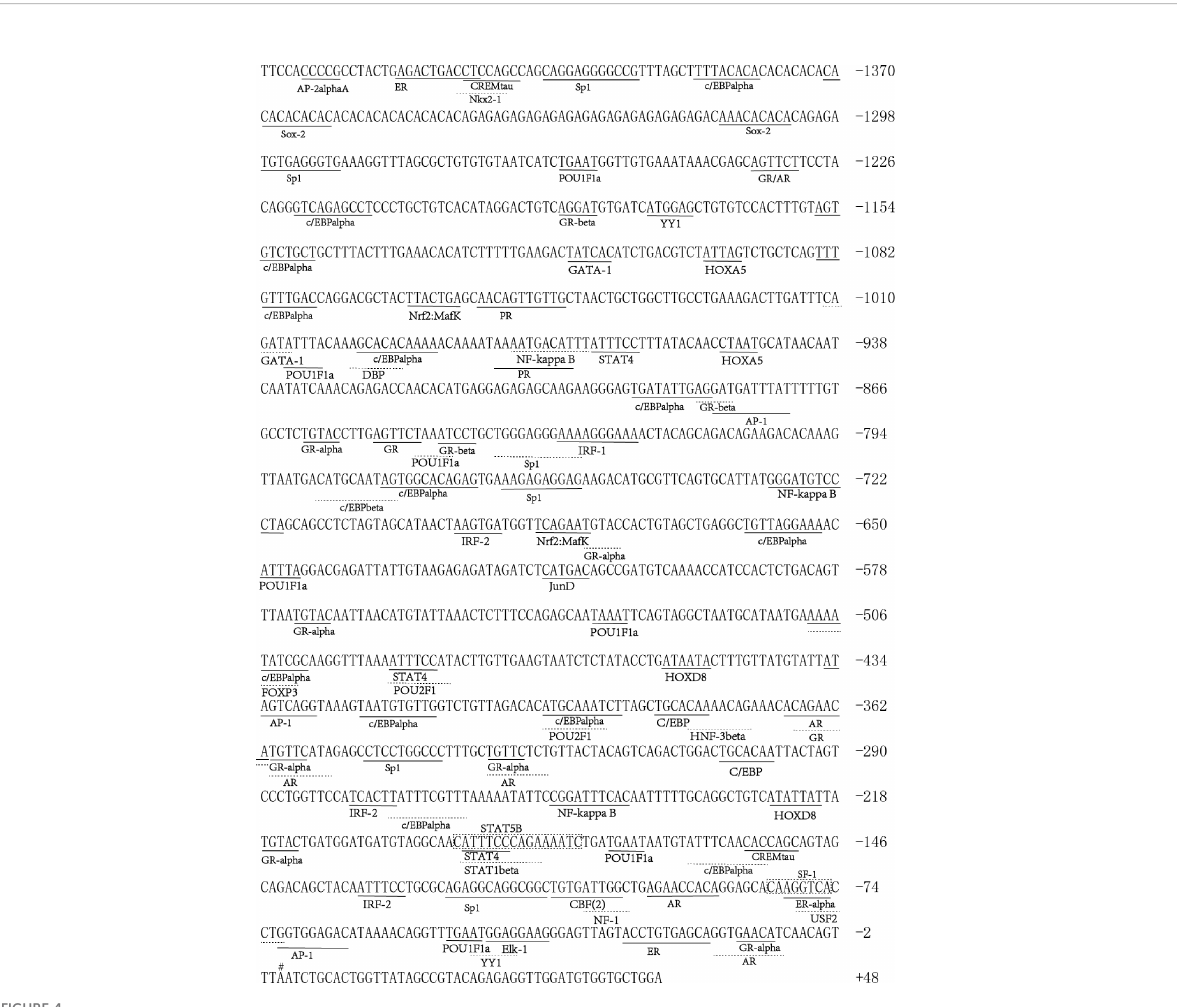
FIGURE 4 Sequence analysis of 5 ′ - fl anking region for kiss2 . The numbering of the sequence is relative to the transcription start site marked on # and designated as +1. Putative binding sites for transcription factors are underlined and labeled. Transcription factor binding sites were predicted using the online PROMO and gene-regulation